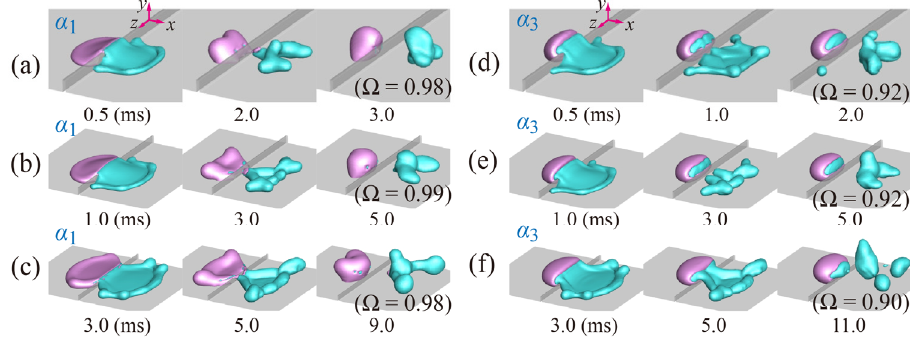
Figure A1. Shape evolutions of the drops with ( a – c ) D 0 = 1.33, 2.0, and 3.0 mm under the viscosity ratios of α 1 , respectively, and ( d – f ) D 0 = 1.33, 2.0, and 3.0 mm under the viscosity ratios of α 3 , respectively. The sizes of the ridges shown in ( a – f ) are controlled to the height of h/D 0 = 0.2 and width of w/D 0 = 0.05. The Weber number in ( a – f ) corresponds to We w = 61.